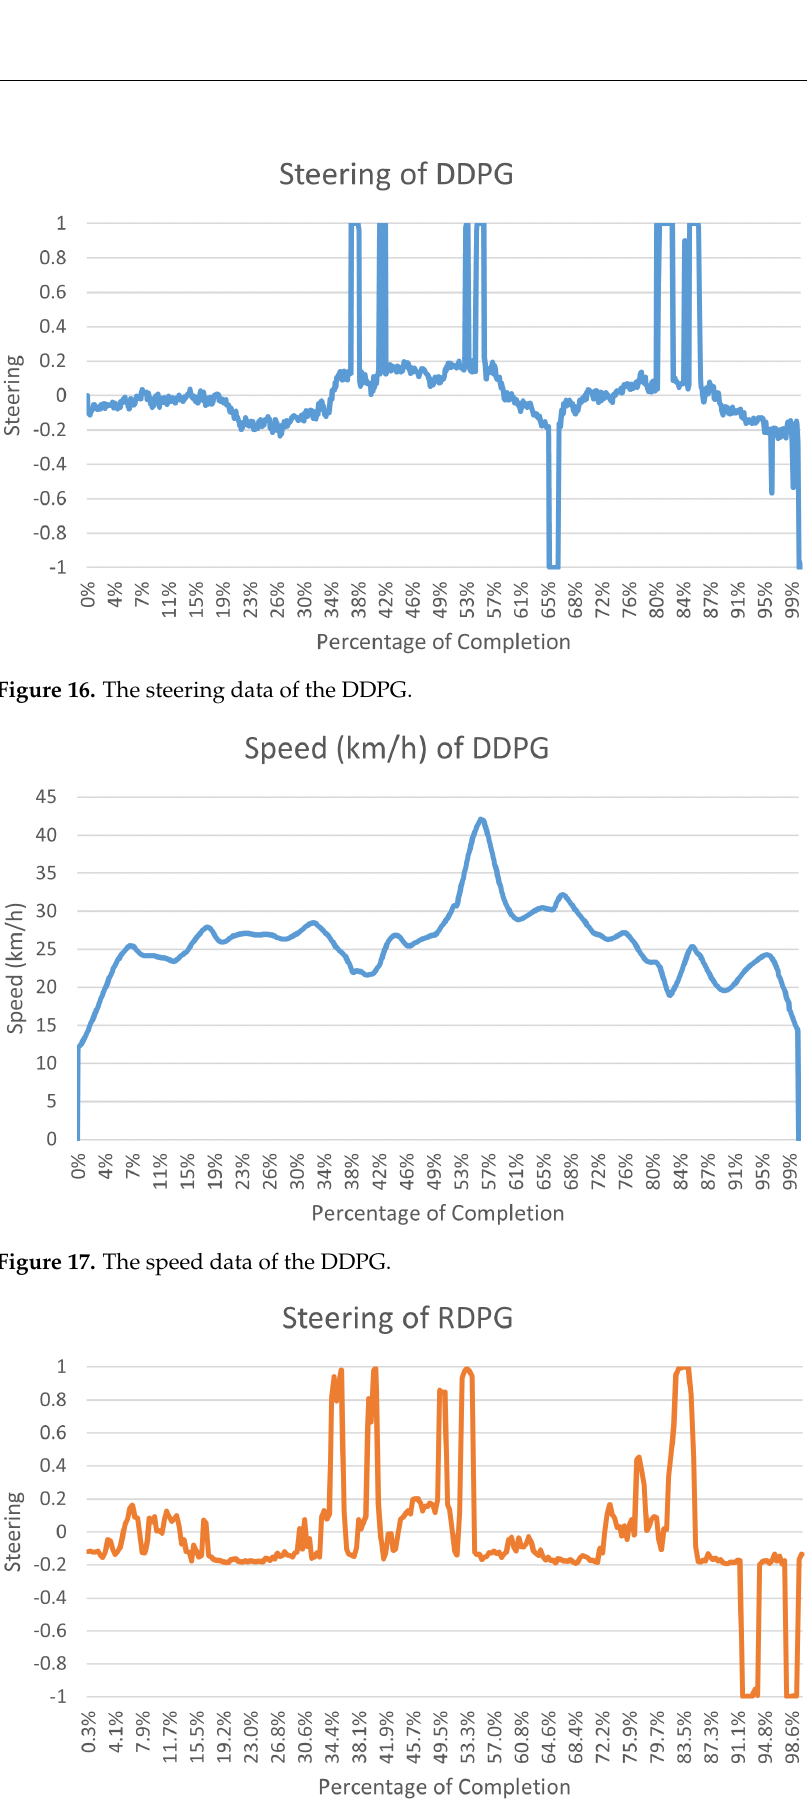
Figure 18. The steering data of the